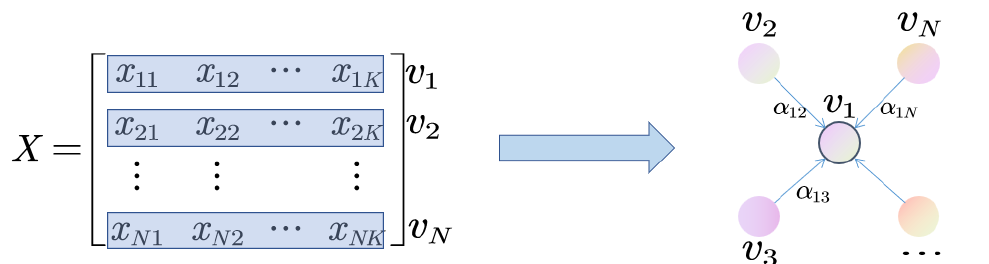
Figure 3. Schematic diagram of constructing a time-based graph attention